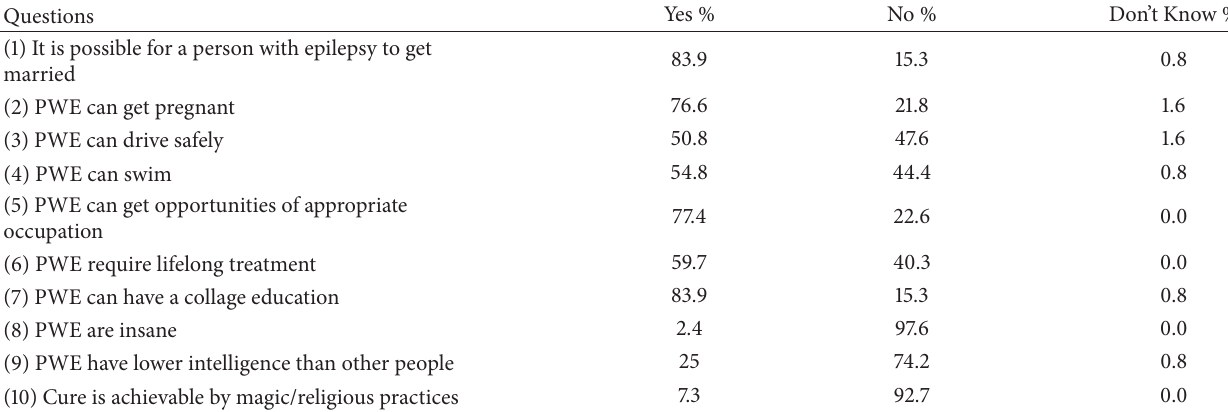
Table 3: Responses to questions related to attitudes toward